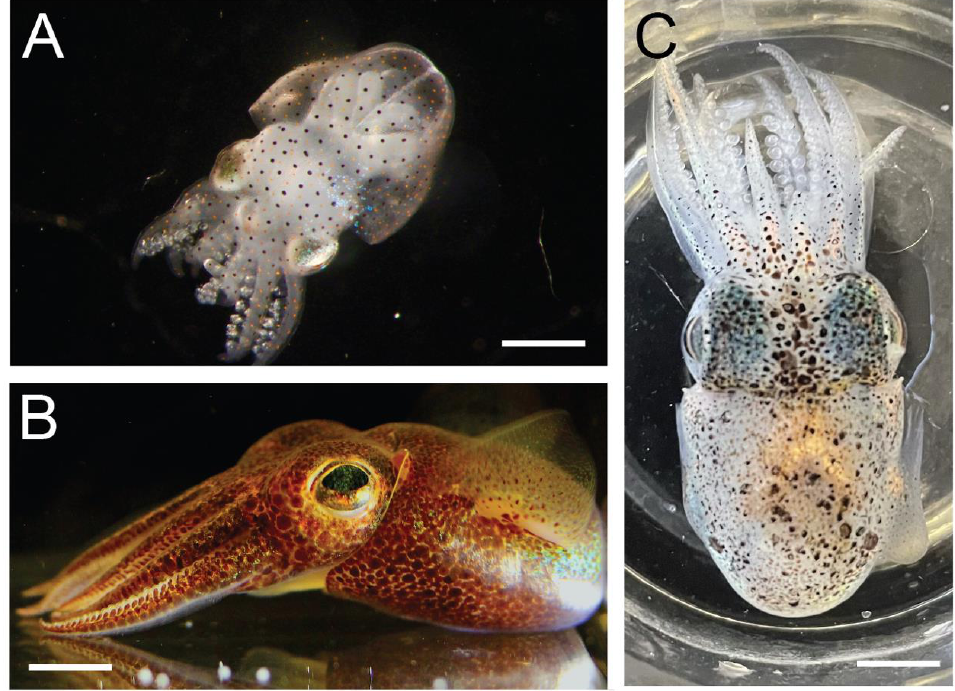
Figure 1. Euprymna berryi , ( A ) Hatchling ( B ) Pre-reproductive adult ( C ) Senescent adult. All squid were captive bred in the laboratory for this study . Scale bars are 500 µm ( A ), and 5 mm ( B , C ). were captive bred in the laboratory for this study. Scale bars are 500 µ m ( A ), and 5 mm ( B , C